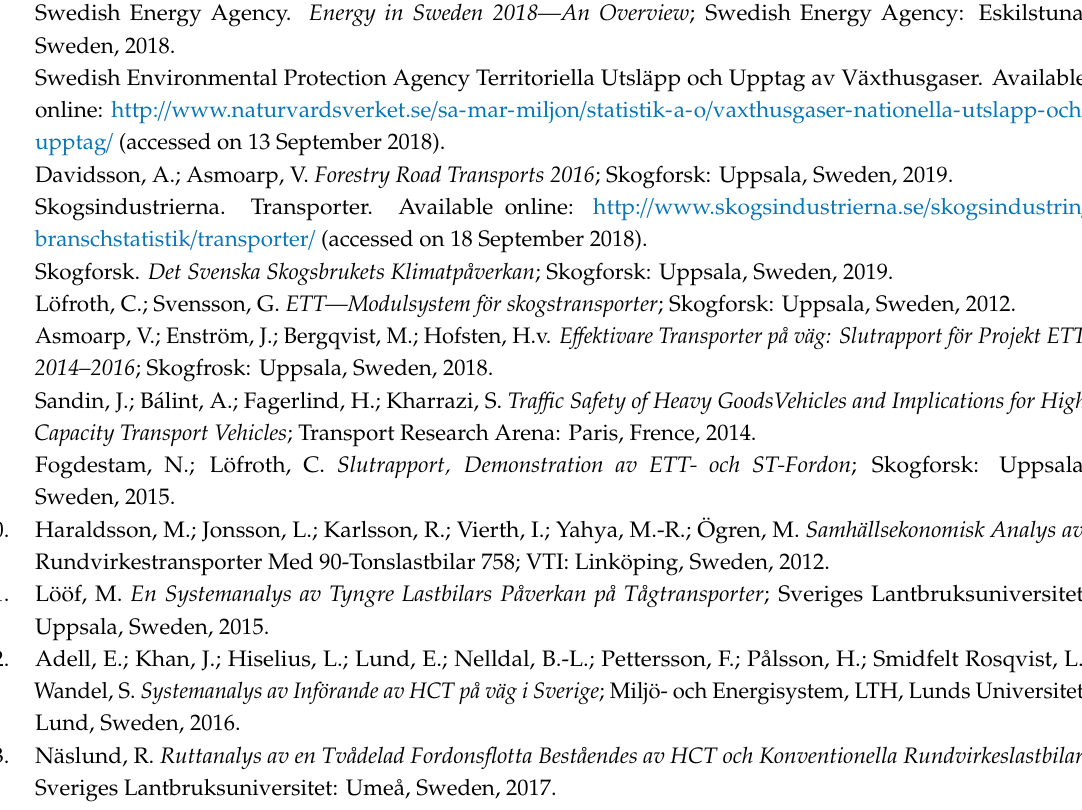
Figure A2. Left: potential HCT corridors (orange) and their connected terminals (red). Middle: buffer areas (blue) around corridor’s endpoints (terminals). Right: identified clustered corridors.